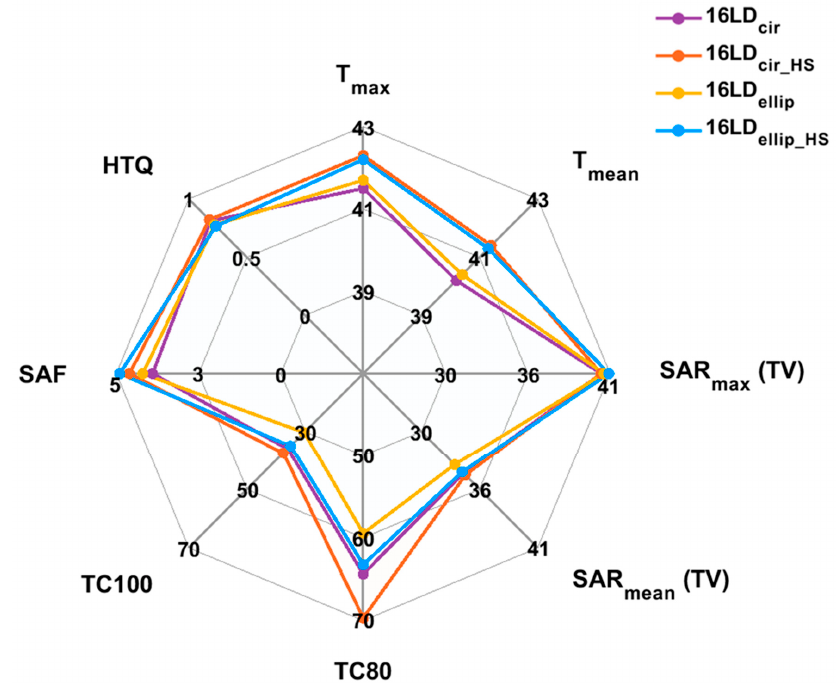
Figure 13. Overall performance evaluation of ThermalMR RF applicators 16LD cir , 16LD ellip , 16LD